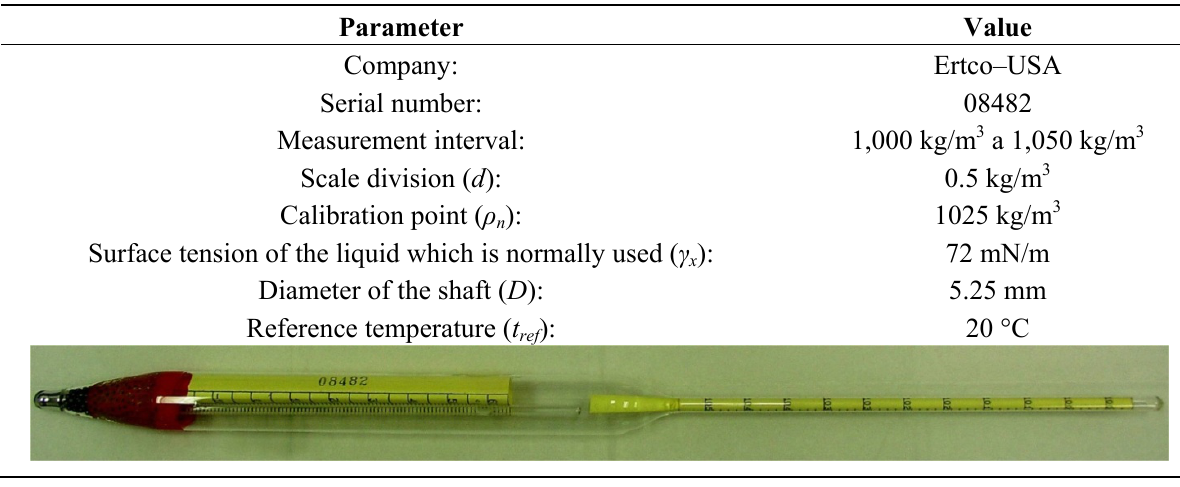
Table 2. Characteristics of the medium accuracy immersion hydrometer.